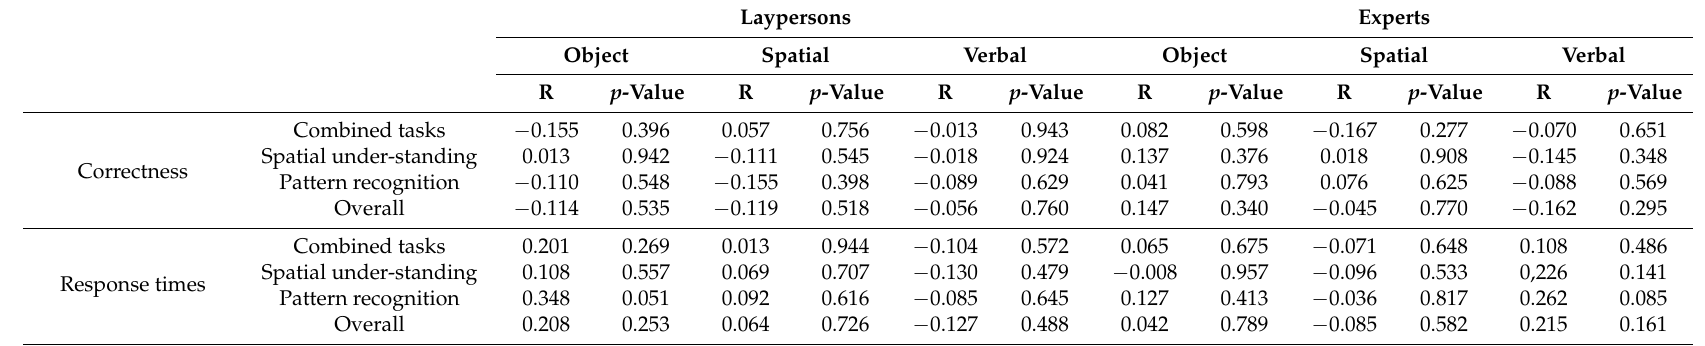
Table 8. Correlation coefficient (significance level α = 0.05) for correctness, response times, and cognitive styles measured via Object-Spatial Imagery and Verbal Questionnaire (OSIVQ) (spatial, object, and